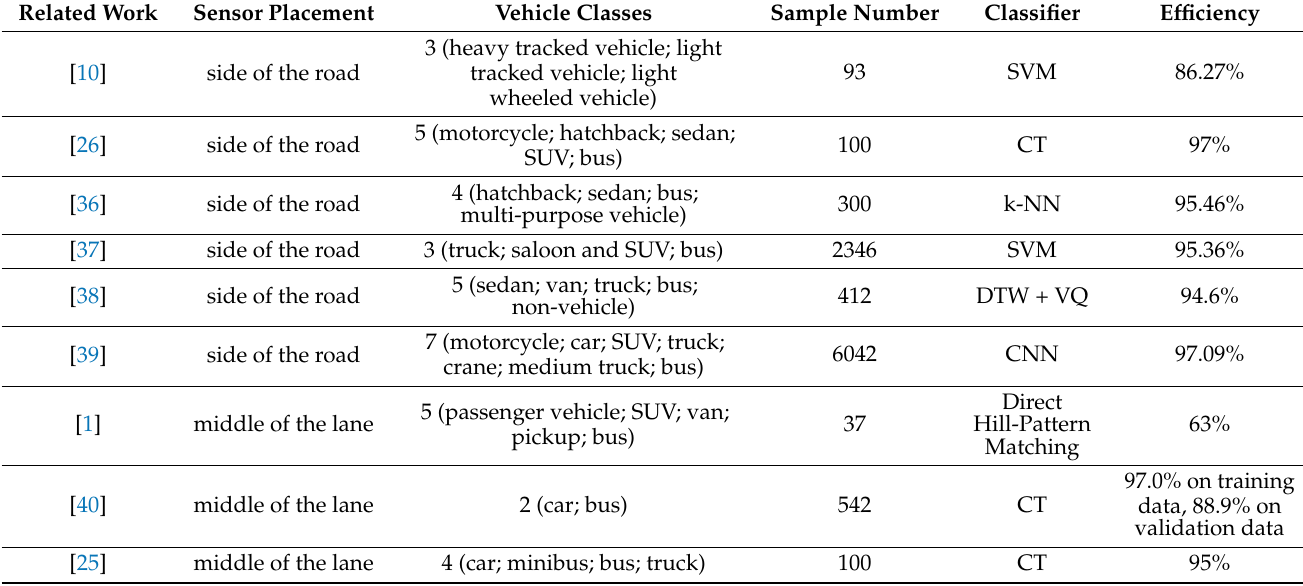
Table 1. Summary of relevant